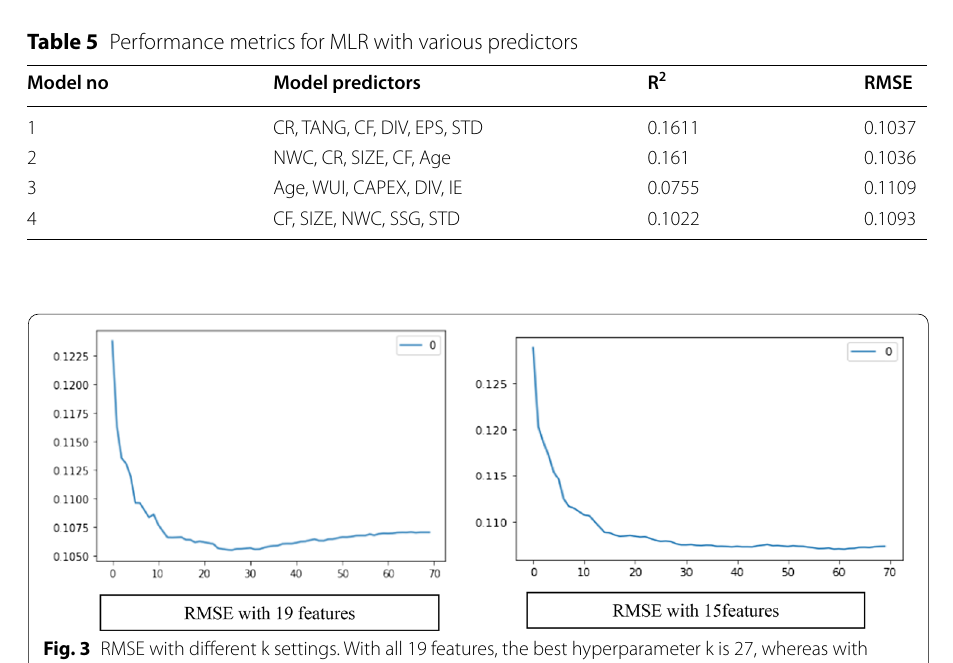
Table 6 Performance metrics with KNN KNN Model with 19 features Model with